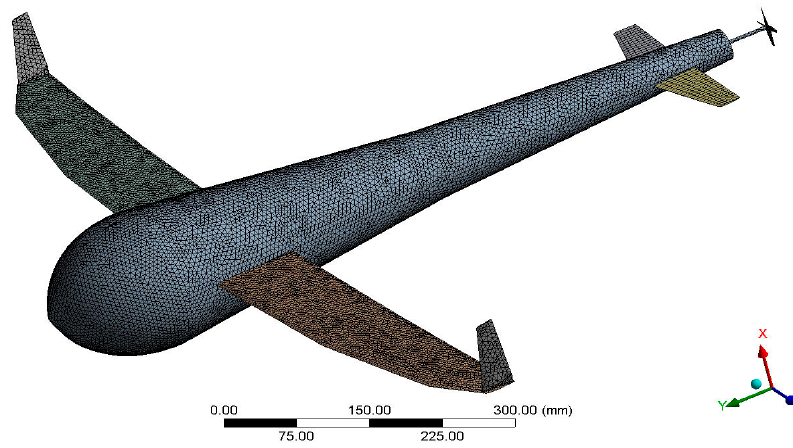
Figure 12. Meshed structure of UAV for HSI simulation.